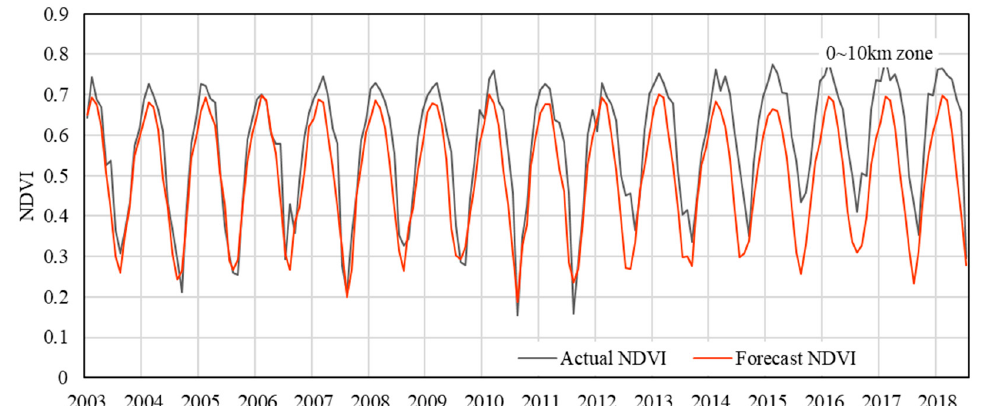
Figure 9. Observed and predicted value of NDVI after impoundment. Table 4. Slopes of residual trends and test results.